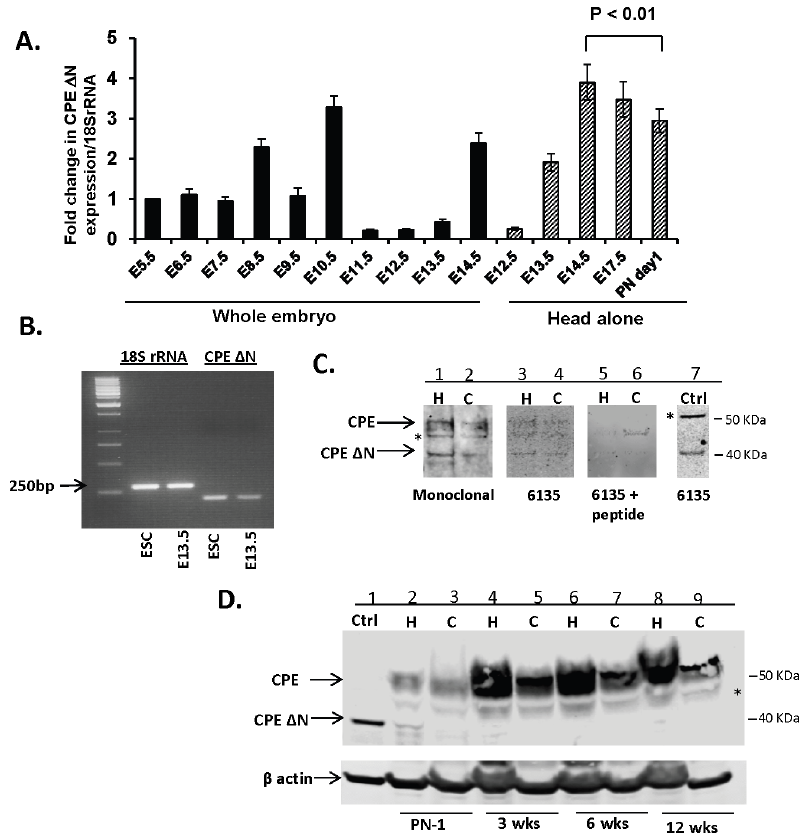
Figure 1. Expression of CPE- D N in embryos, embryonic neurons and adult brain. A. Bar graph represents the fold change in CPE- D N mRNA levels in whole mouse embryos and head alone at gestational ages from E5.5–E17.5 and postnatal day 1 (PN1) compared to E5.5. Each bar represents results from 3 embryos or head, each one obtained from 3 individual mice. The RT-PCR was done in triplicates. Note the significant decrease in the CPE- D N mRNA levels from head of E14.5 embryos to PN1 mice ( t test, n 5 3, p , 0.01). B. Semi-quantitative PCR of CPE- D N transcripts. Representative gel (n 5 3) showing 18S rRNA and 200 bp CPE- D N transcripts from mouse E13.5 cortical cells and embryonic stem cells (ESC). C. Representative Western blot showing WT and CPE- D N protein in rat E18 hippocampal (H) and cortical (C) neurons visualized by 2 different antibodies: mouse monoclonal antibody, (lanes 1, 2), rabbit polyclonal antibody # 6135 (lanes 3, 4) and absorption control using the antigenic peptide used to generate antibody # 6135 (lanes 5, 6). A positive control (Ctrl) using HCC cells transduced with cpe- D N construct (lane 7). * denotes non-specific band. N 5 3. D. Representative Western blot (N 5 3) showing the expression of CPE- D N and CPE from hippocampus (H) (lanes: 2, 4, 6, 8) and cortex (C) (lanes 3, 5, 7, 9) of mice at PN1, 3, 6 and 12 weeks of age and positive control (Ctrl. using HCC cells transduced with cpe- D N construct) (lane 1), probed with mouse monoclonal antibody. * denotes non-specific